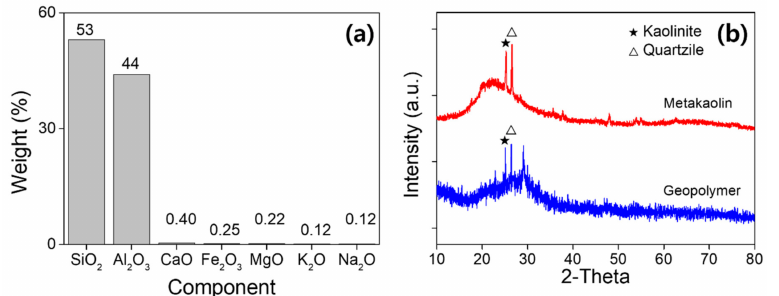
Figure 1. ( a ) X-ray fluorescence component analysis of metakaolin powder. ( b ) XRD results of metakaolin and cured